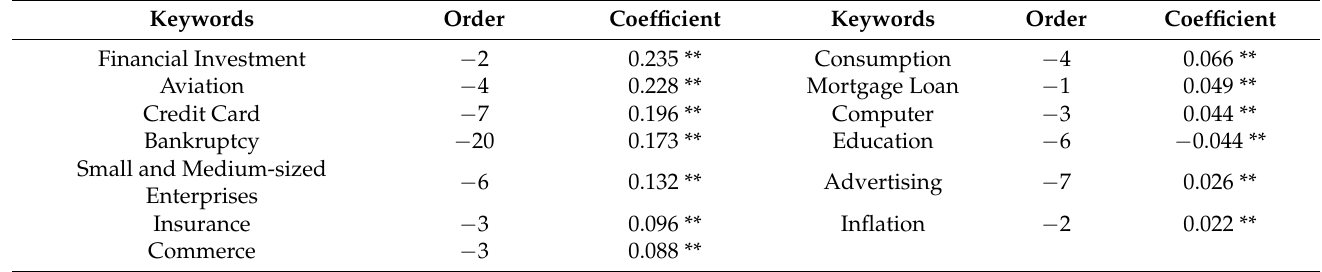
Table 3 show 13 negative keywords. The negative ones are the antecedent keywords used as the filtered keywords. The filtered keywords are used for